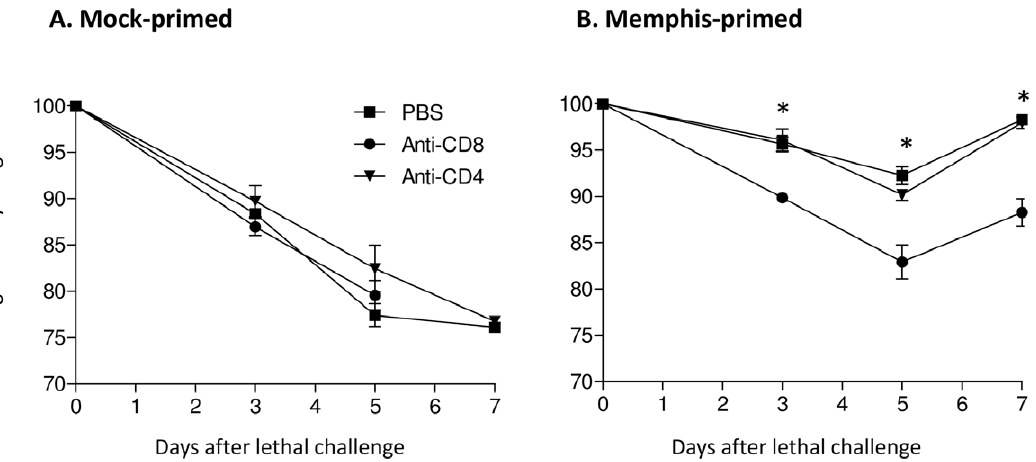
Figure 3. Effect of CD8- or CD4 T cell depletion on heterosubtypic immunity. Five B6 mice per group were primed intranasally as described in figure 1. Mock-primed (A) or Memphis virus-primed (B) animals were depleted of either CD8- or CD4 T cell subset in vivo as described in Materials and Methods. Monitoring of body weight loss after lethal challenge with Taiwan virus and expression of the results were described in detail in figure 1. One representative result is shown from two independent studies with similar results. Asterisk (*) indicates a statistically significant difference when CD8-depleted group was compared with PBS control group.